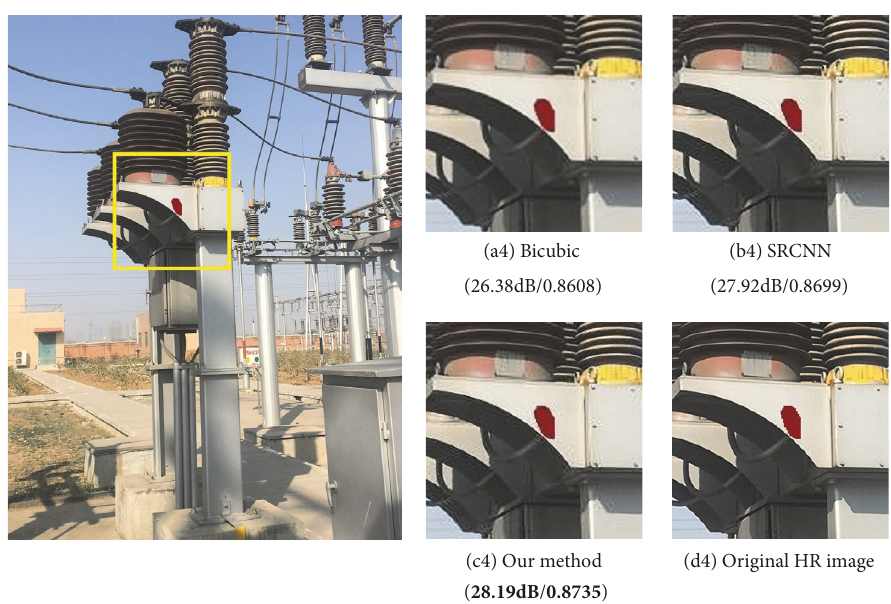
Figure 8: Simulating the rust in the circuit